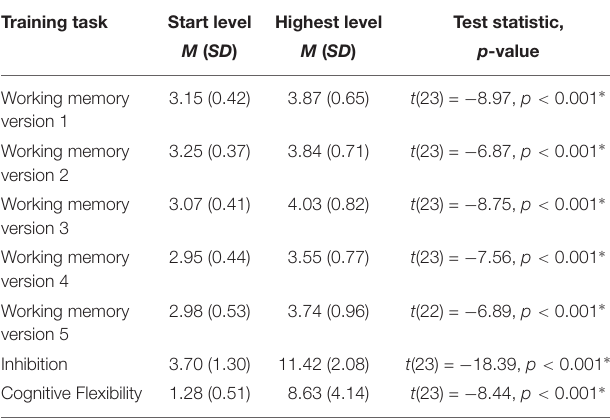
TABLE 2 | Improvement during training on the training